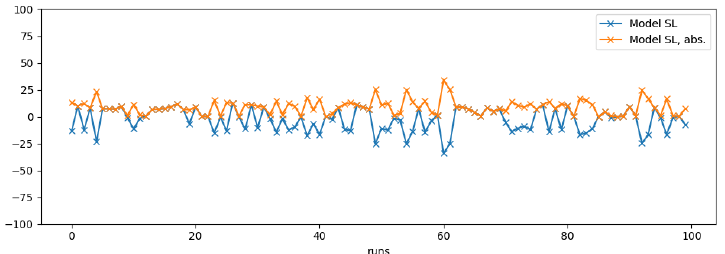
Figure 10. Relative error and its absolute value for 100 test runs with random stream